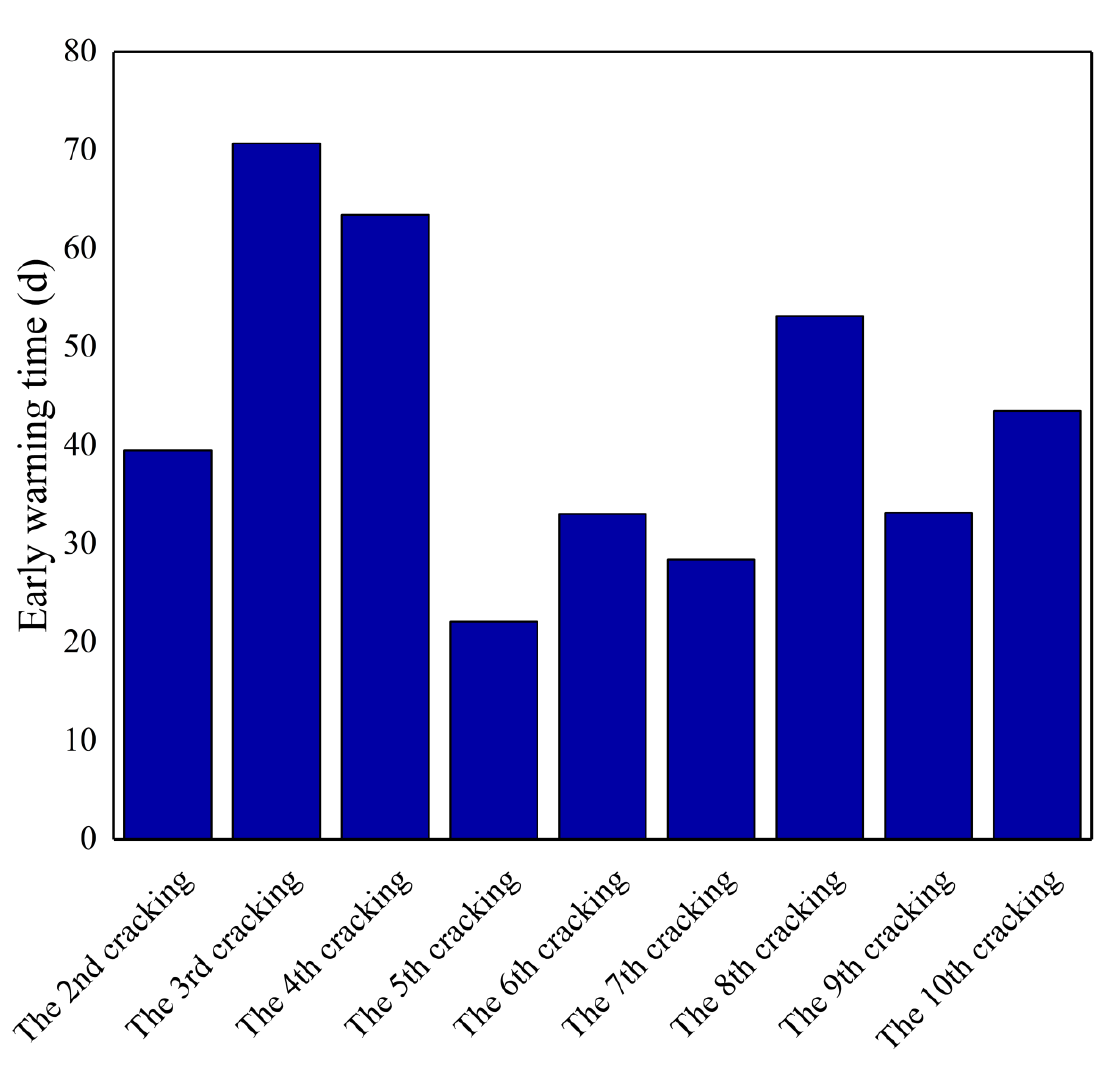
Figure 16. The early warning times (i.e., the period between the actual cracking time and the estimated lower limit of cracking time) for the crest cracking